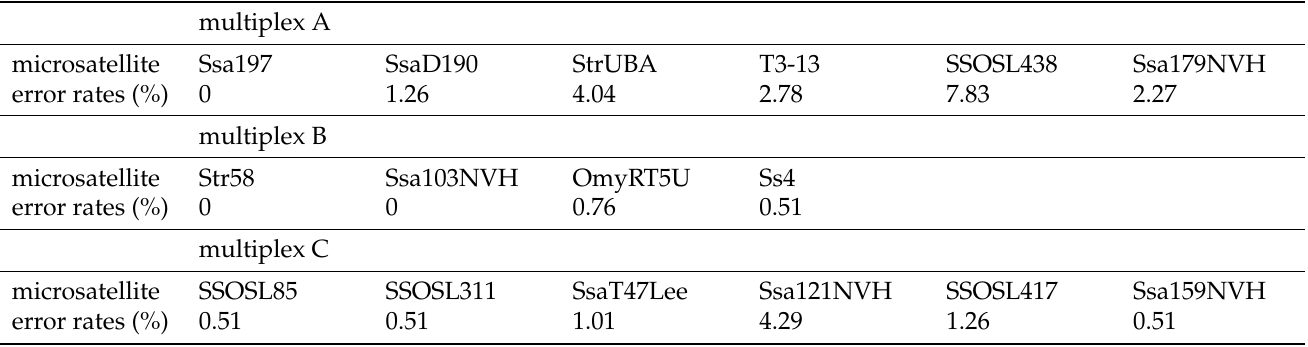
Table A1. Error rates for microsatellite markers arranged by multiplex (i.e., arrangement of markers in sets for simultaneous PCR